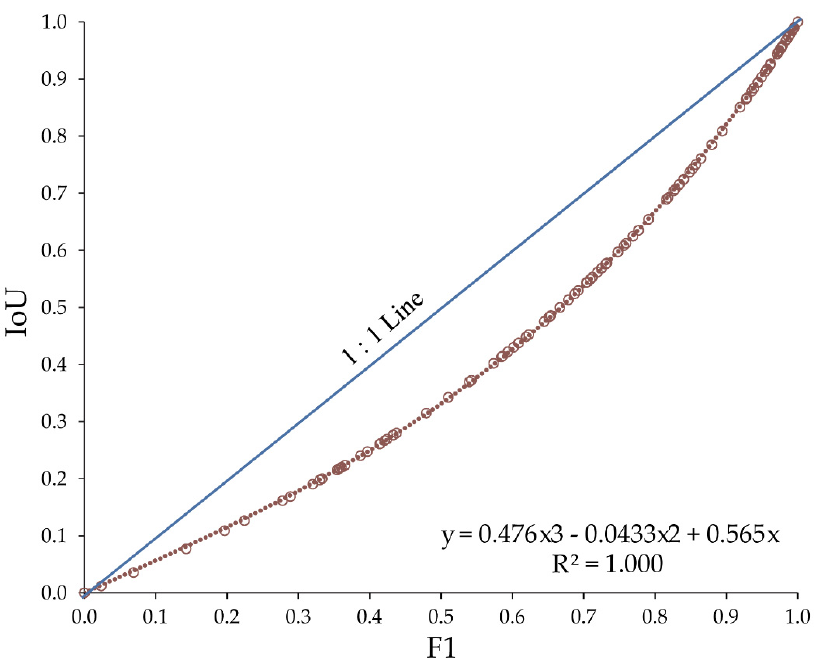
Figure 4. Graph of F1 vs. IoU for 100 randomly generated points, illustrating the correlated nature of these two measures of accuracy. Each random reference point is represented as a circle with the associated dotted line representing the perfect and non-linear correlation between F1 score and IoU. The blue line represents a perfectly linear, 1:1 correlation for reference.